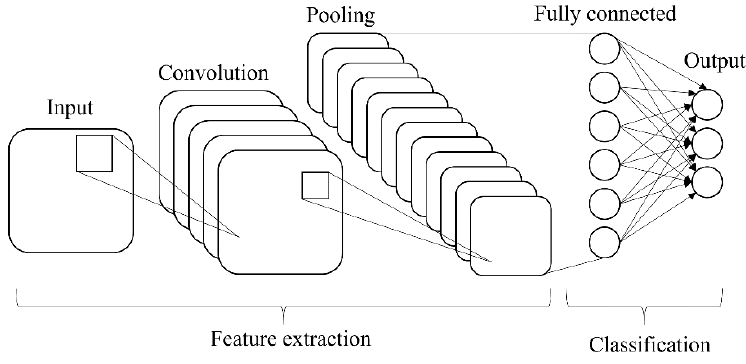
Figure 4. Basic architecture of CNN.